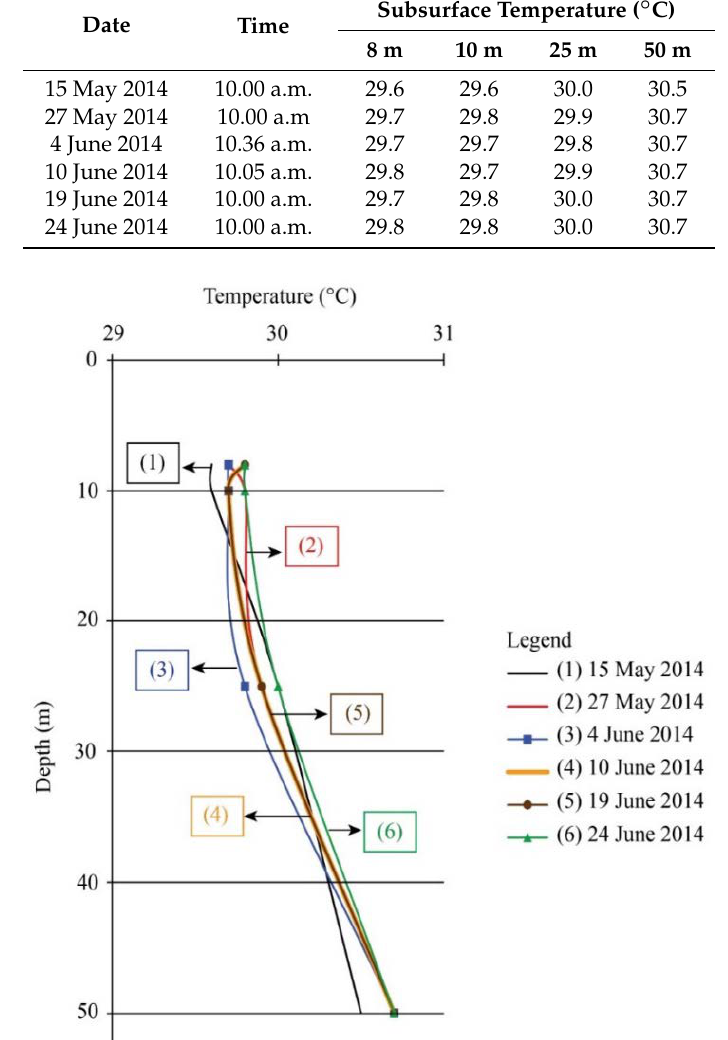
Table 1. Subsurface temperature measurement at depths of 8, 10, 25 and 50 m in 6 days measurement (short-time measurements).